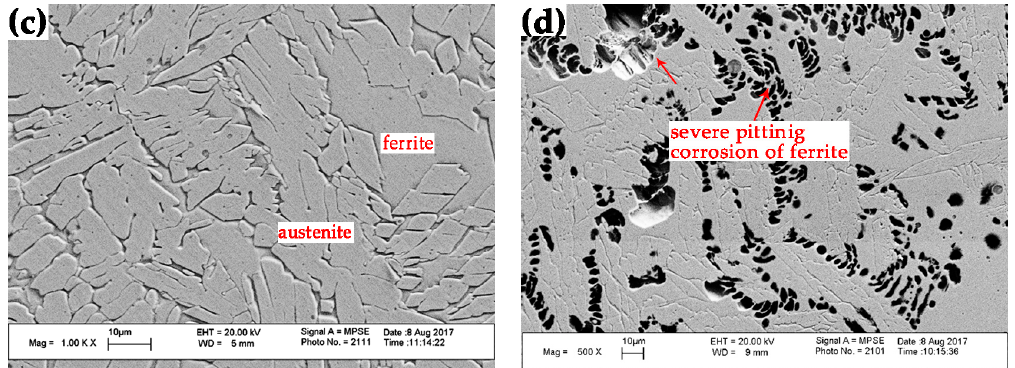
Figure 12. SEM images of pitting morphologies formed at 0.5 V sce at 50 °C: severely pitting corrosion in ferrite of ( a ) Specimen 1, ( b ) Specimen 2 and ( d ) Specimen 4; and no obvious cluster pits of ( c ) Specimen 3.